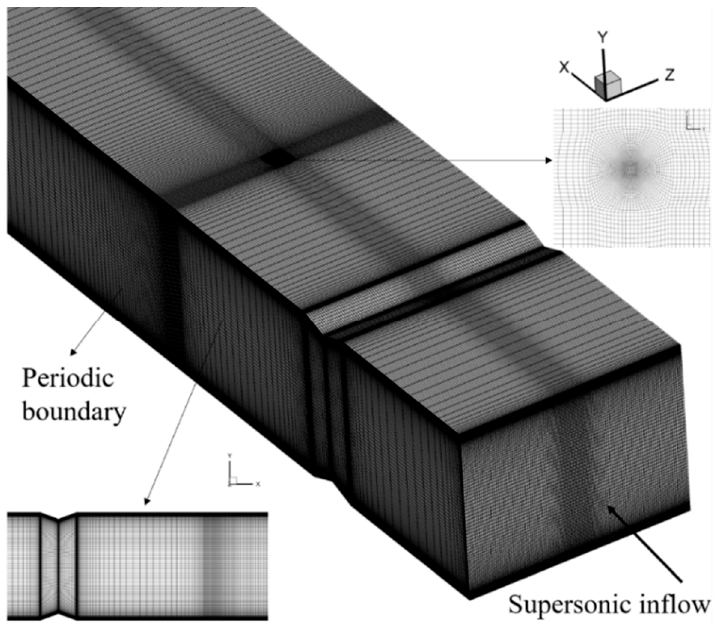
Figure 4. Grid diagram of computational domain and fuel injection orifice.